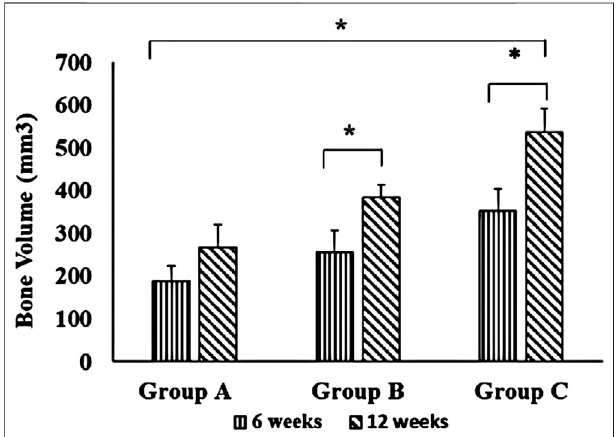
FIGURE 1 | Comparison of bone volume between groups (group A (control), group B (chitosan gel), group C (OPG-chitosan gel)). at 6 and 12 weeks. Data are expressed as mean ± SD ( n (cid:1) 3). *denotes signi fi cant difference in bone volume ( p < 0.05) found between different